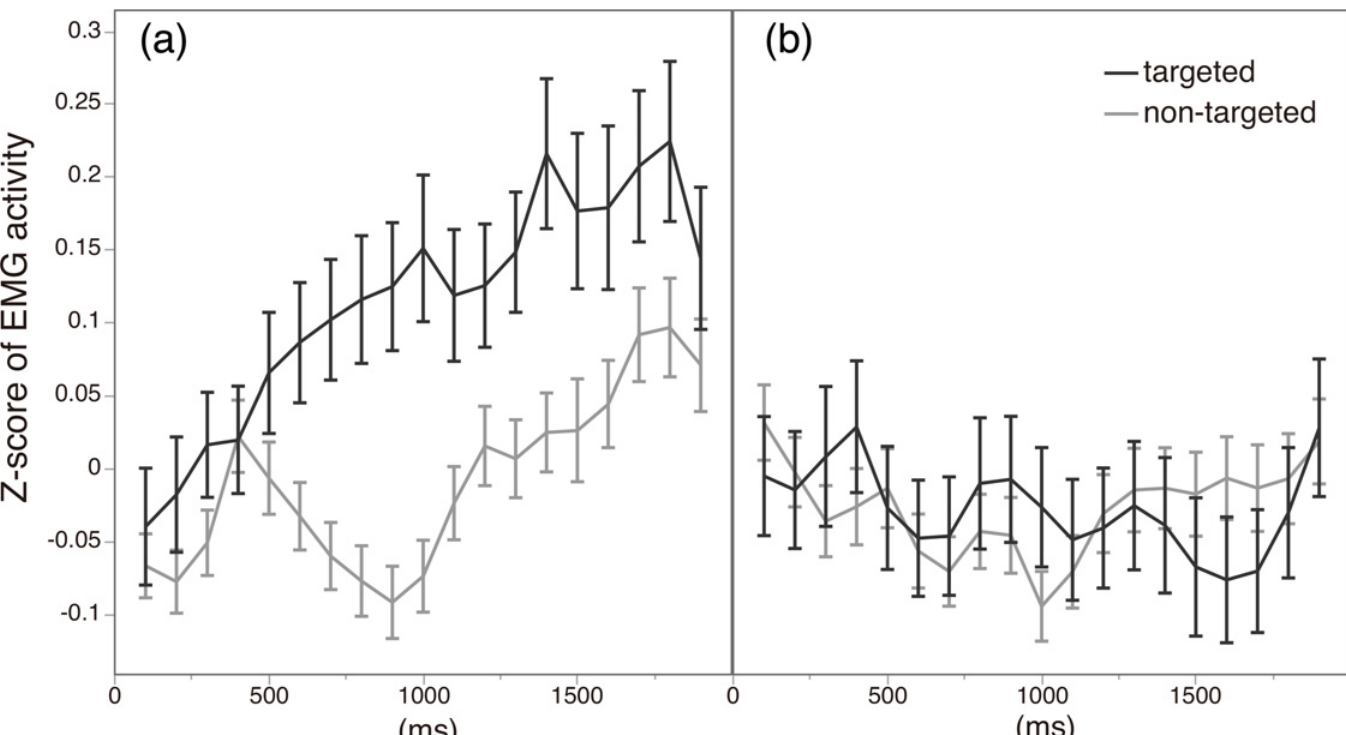
Fig 4. Time course of EMG activity of targeted and non-targeted muscles from morphing onset in (a) the Emotion-Inference condition and (b) the Passive condition. The horizontal axis shows time elapsed from morphing onset (in milliseconds), and the vertical axis shows z-score of EMG amplitude for each muscle type. Error bars represent standard error of the mean at each time